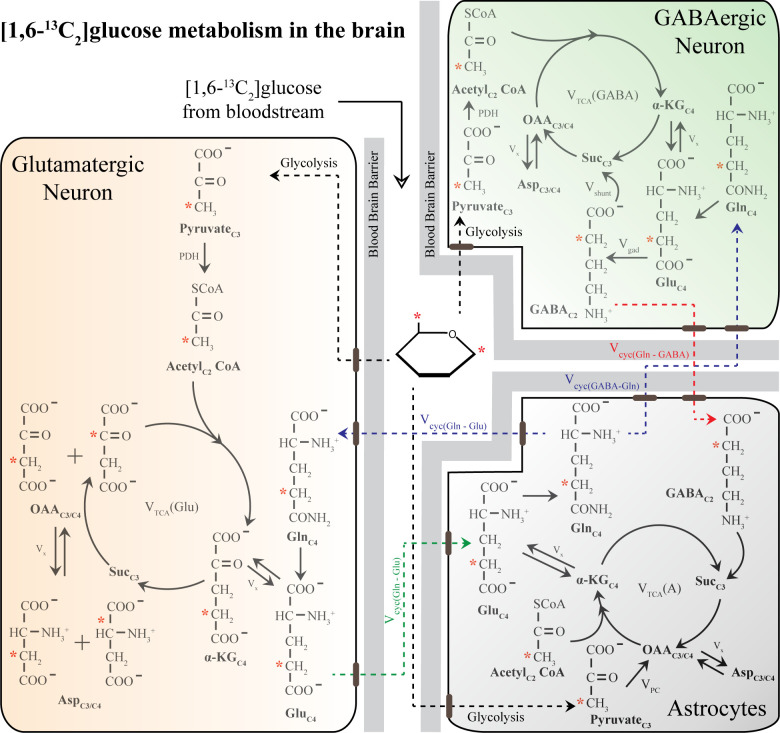
Schematic of 13C labeling of various metabolites from [1,6-13C2]glucose in a three-compartment metabolic model [1,6-13C2]glucose is converted to PyruvateC3 via glycolysis and subsequently enters the TCA cycle.Metabolism of [1,6-13C2]glucose in glutamatergic and GABAergic neurons produces GluC4, which is then decarboxylated to GABAC2 by GAD enzyme in GABAergic neurons. The glutamate–glutamine and GABA-glutamine cycle operating between neurons and astrocytes produce GlnC4. Other versions of 13C-labeled glutamate (GluC4) and GABA (GABAC4) are produced in the subsequent metabolism of GluC4 and GABAC2. In the astrocytes, PyruvateC3 can enter the TCA cycle via the pyruvate carboxylate pathway and subsequently produce the 13C-labeled metabolites namely GlnC2, GluC2, and GABAC4. Only the first round of TCA cycle is depicted here for simplicity. Abbreviations: αKG: α-ketoglutarate; OAA: oxaloacetate; Asp: aspartate; Suc: succinate; GABA: γ-aminobutyric acid; GAD: glutamic acid decarboxylase; Glu: glutamate; Gln: glutamine; Vcyc(GABA-Gln): GABA-glutamine cycling flux; Vcyc(Glu-Gln): glutamate–glutamine cycling flux; Vgad: glutamate decarboxylase flux; Vgln: glutamine synthesis rate; Vpc: pyruvate carboxylase flux; Vshunt: flux of GABA shunt; VTCA(A): Astroglial TCA cycle flux; VTCA(GABA), GABAergic TCA cycle flux; VTCA(Glu): glutamatergic TCA cycle flux; Vx: exchange rate between a ketoglutarate and glutamate. ∗ represents the position of the 13C carbon.